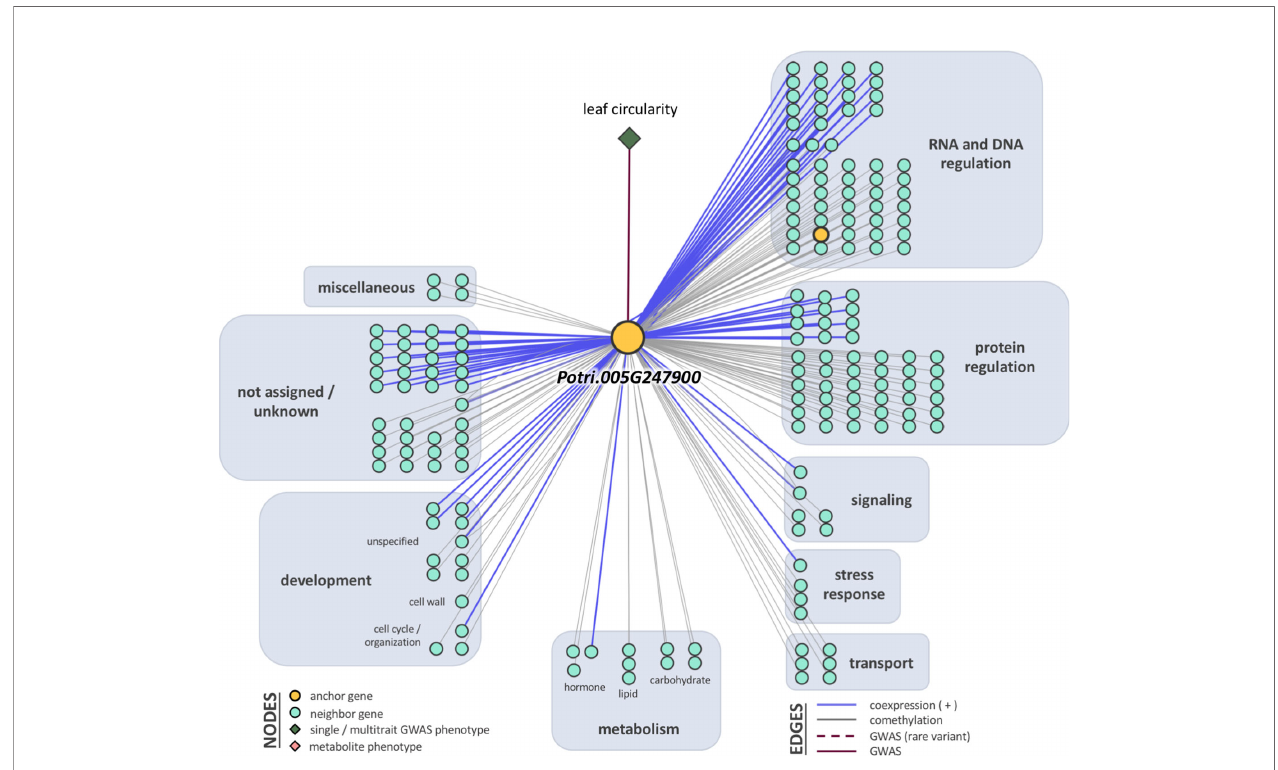
FIGURE 8 | One-hop multi-omic network for the gene Potri.019G067300, which was associated with the multitrait phenotype leaf area, leaf dry weight, leaf length, and leaf width